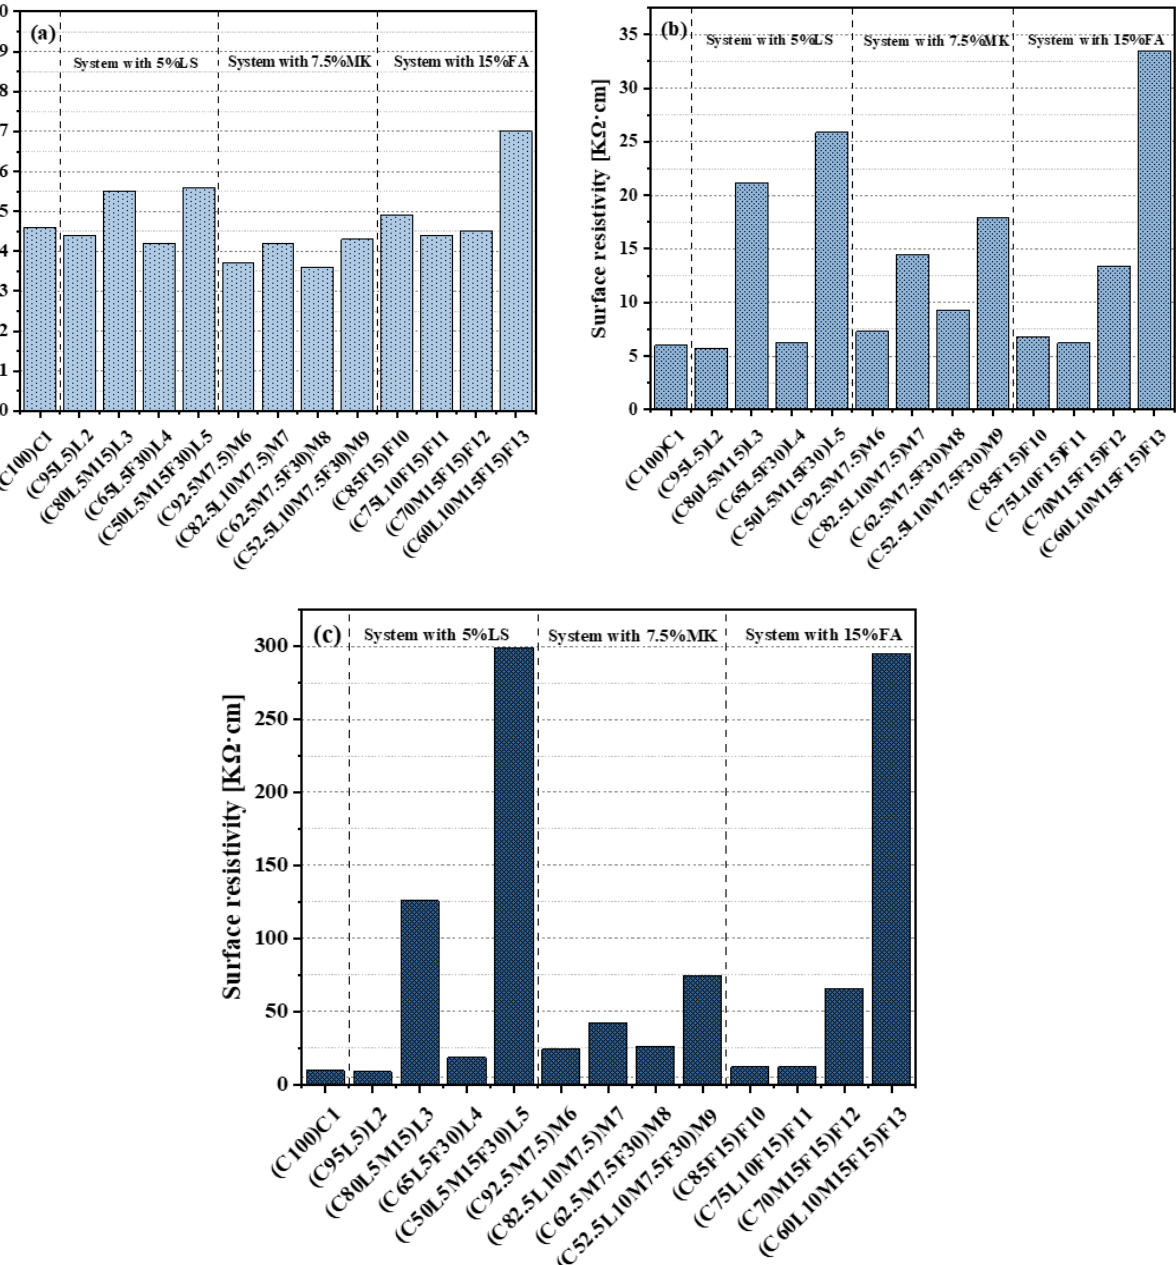
Figure 8. Surface resistivity: ( a ) Surface resistivity at 3 days; ( b ) surface resistivity at 7 days; ( c ) surface resistivity at 28 days.